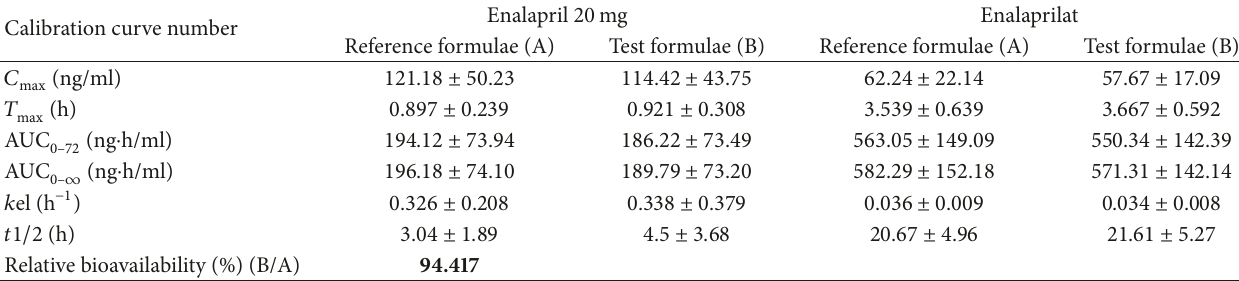
Table 6: Pharmacokinetic parameters of healthy human volunteers with the test and reference formula ( 𝑛 = 30